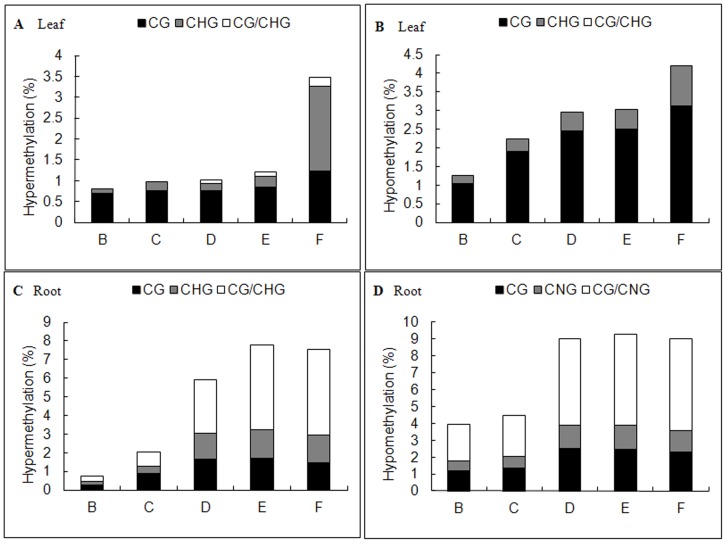
Effects of different salt stresses on hypermethylation (a, c) and hypomethylation (b, d) in C.virgata.B: NaCl, C: Na2SO4, D: NaHCO3, E: Na2CO3, F: Mix.